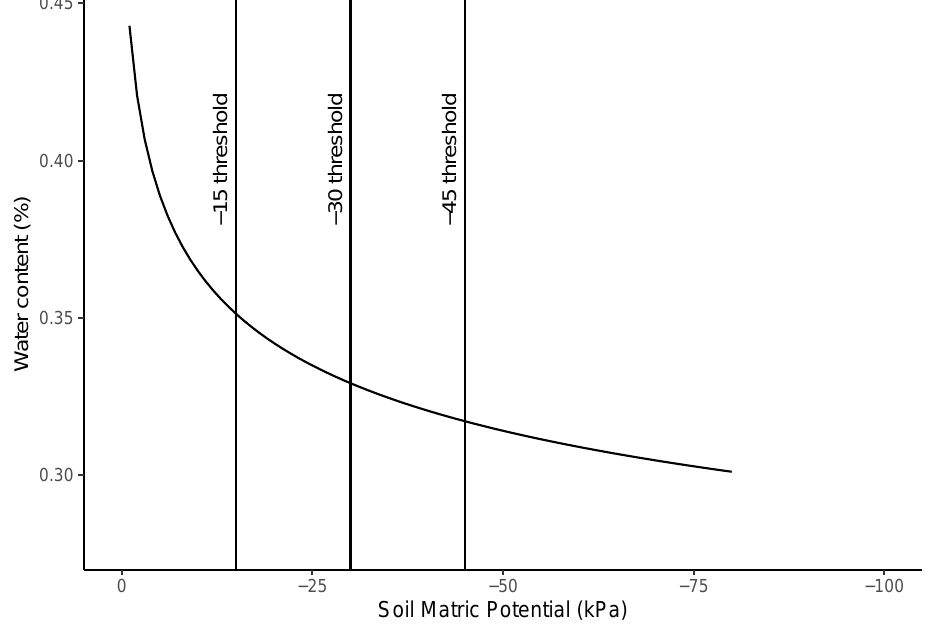
Figure 1. Distribution of the irrigation thresholds (vertical lines) used in this study related to the soil water retention curve (exponentially decreasing